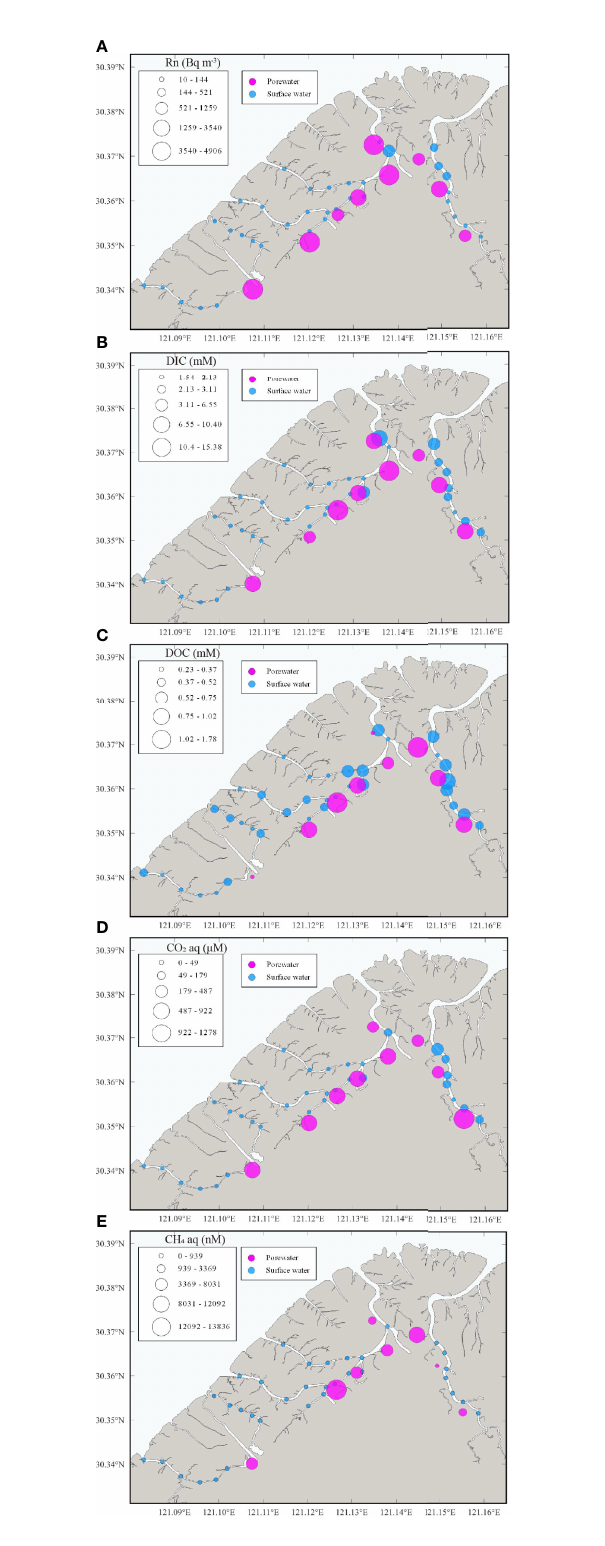
FIGURE 3 | Spatial distributions of (A) 222 Rn, (B) DIC, (C) DOC, (D) CO2 and (E) CH 4 in surface water and porewater.